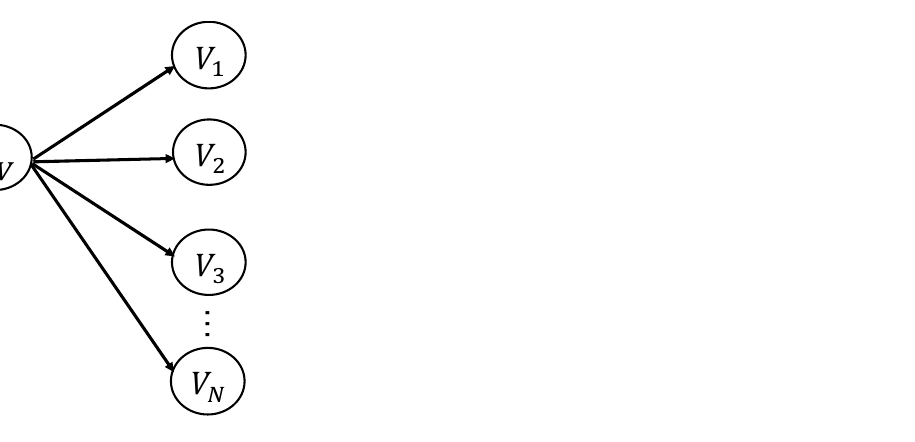
Figure 1. Schematic of the hierarchical model with a parent-node hyperparameter.